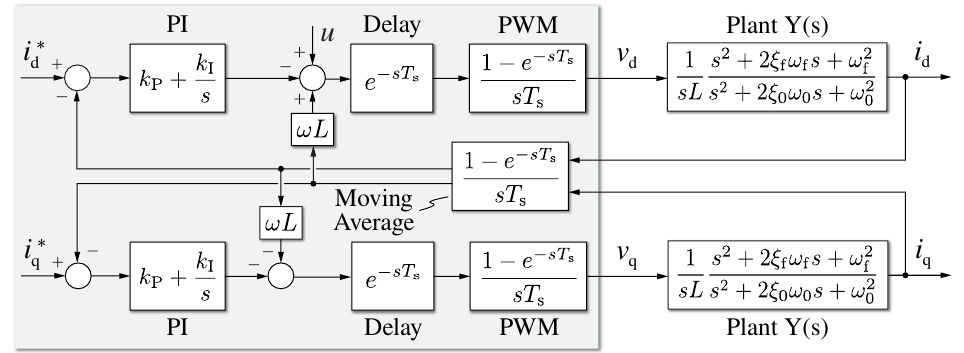
Figure 20. Complete block diagram of the i d and i q current control loops [10], including the plant transfer function Y ( s )